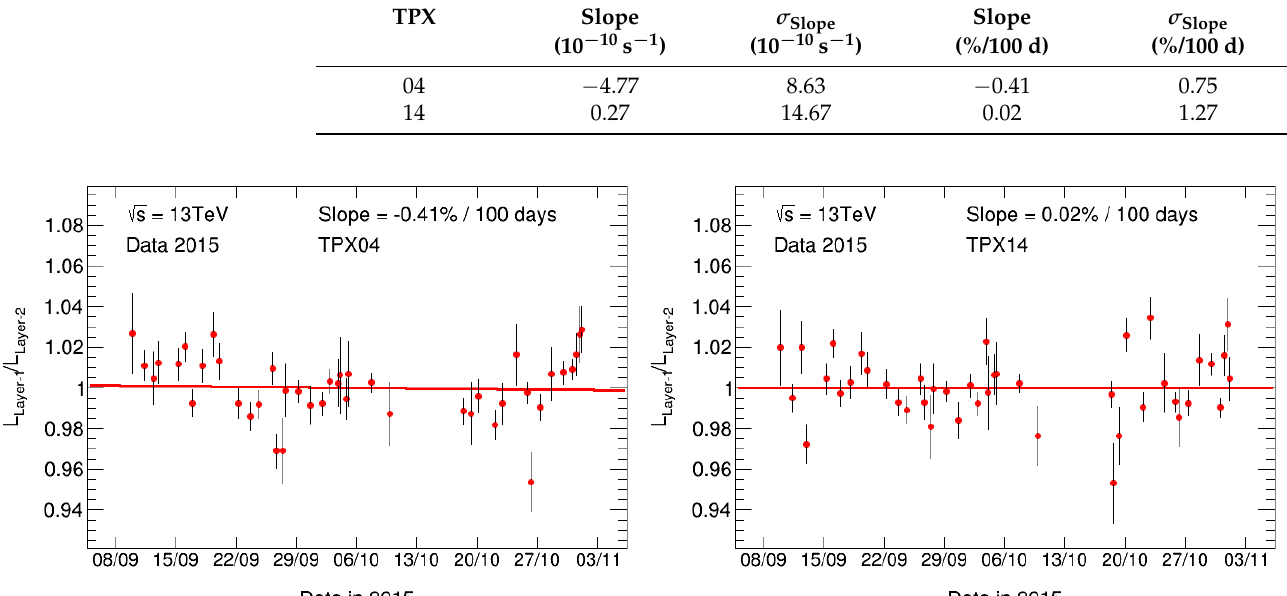
Table 29. Slope of time history of the luminosity ratio measured by layers 1 and 2 for TPX04 and TPX14. The slope values and the uncertainties are given per second and in percent per 100 days. Taken from Ref. [17].